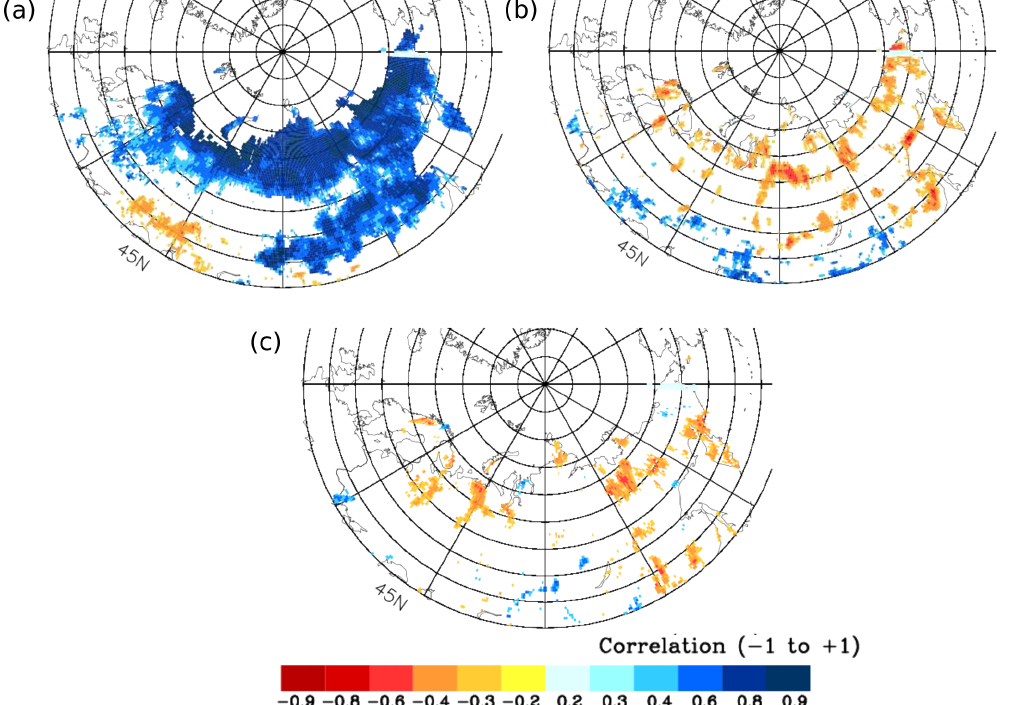
Figure 8. Spatial distribution of statistically significant (95% significance level) partial correlation between de-trended annual GPP (GPPsat) and de-trended summer values of environmental variables (a) temperature, (b) precipitation, and (c) cloud cover. Negative correlations are shown with shades of red and positive correlations are shown in shades of blue.